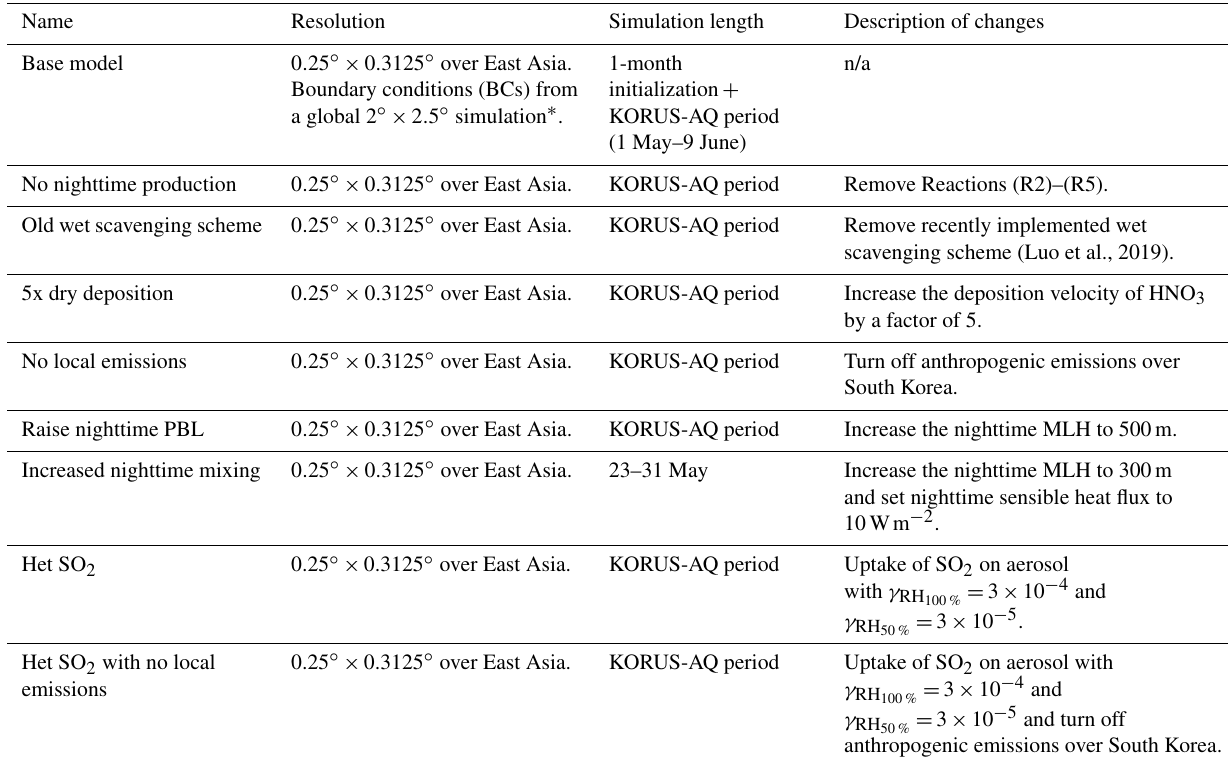
Table 4. Description of model